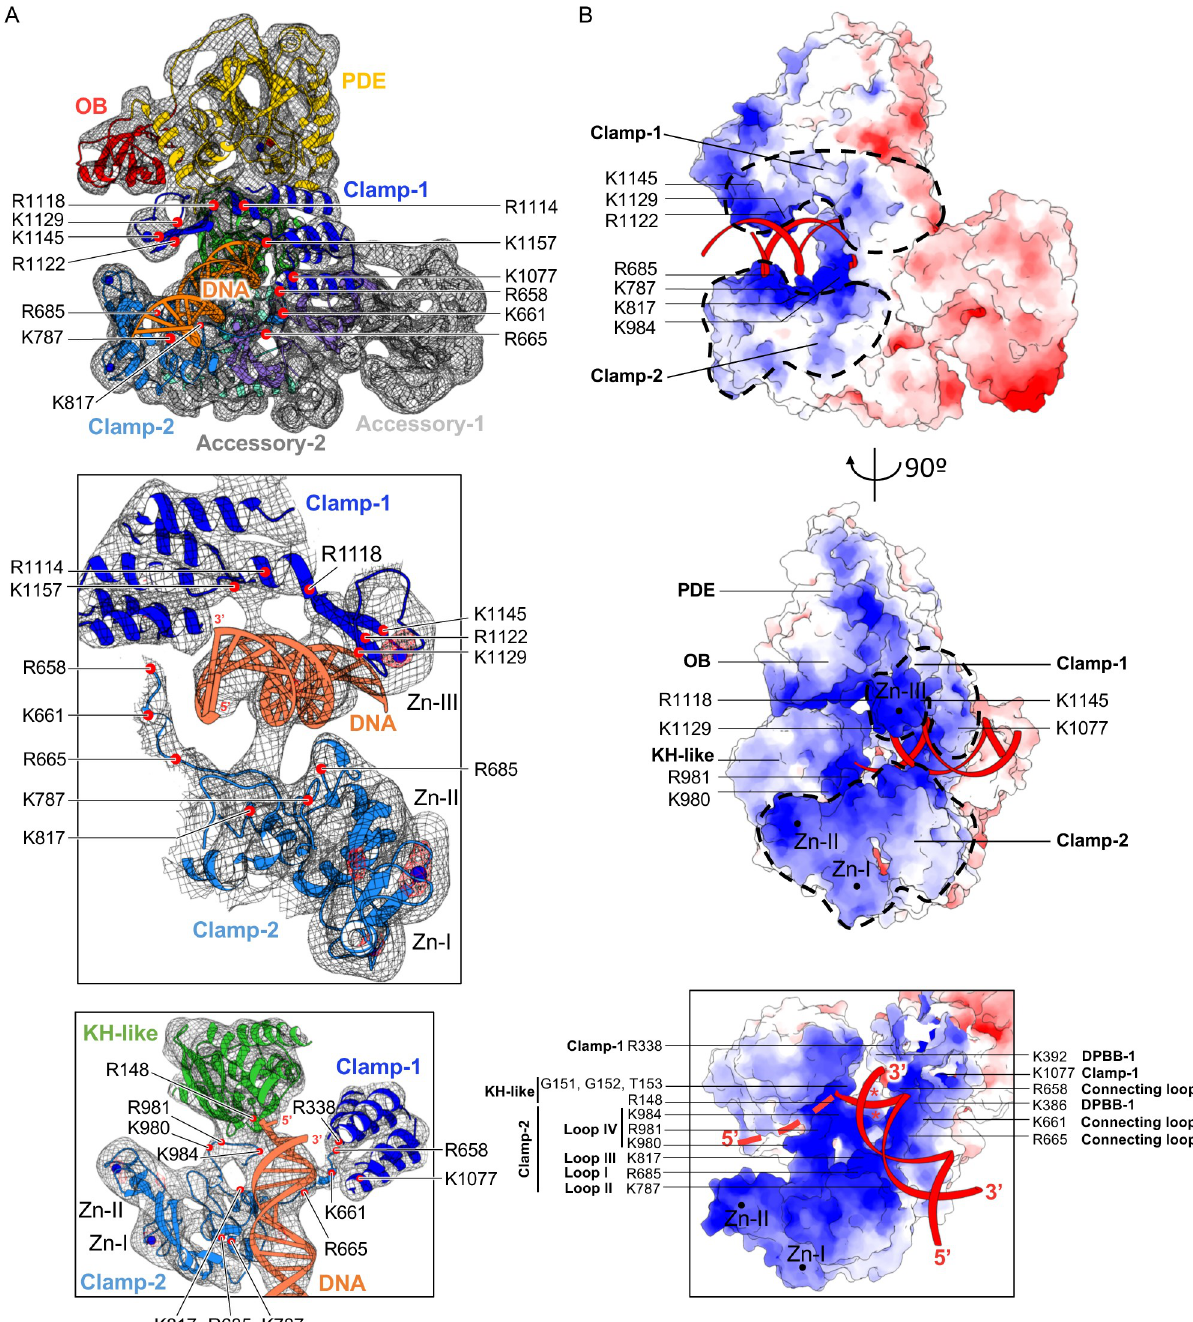
Fig 7. Structure and surface charge distribution of the PolD–DNA-binding site. (A) Selected views of the DNA-bound PolD cryo-EM experimental map. Upper: Overview of the DNA-bound complex. Middle: The minor groove of the nascent DNA duplex is cradled between clamp-1 and clamp-2 domains. Lower: Enlarged view showing the contributions of clamp-1, clamp-2, and the KH-like domain to the PolD–DNA-binding site. For clarity, the Zn-III binding domain is hidden. Density surrounding PolD and DNA is shown as a gray mesh contoured at 6 σ . Residual peaks of density are shown in red mesh contoured at 12 σ . C α of conserved basic residues are shown as red spheres. (B) Surface charge distribution of the PolD–DNA- binding site. The surface of PolD is colored according to the electrostatic surface potential, with negative, neutral, and positive charges shown in red, white, and blue, respectively. The electrostatic surface potential was calculated using a PolD model containing all side-chain atoms. All side chains of DP1 and most side chains of DP2 (86%) were deduced from the existing crystal structures; the others were modeled according to the most likely rotamers. Catalytic aspartic residues are marked by a red asterisk. Zn-binding domains are depicted with black spheres. Clamp-1 and clamp-2 domains are highlighted by dotted lines. The DNA backbone is colored red, and the last 4 nt of the 5 0 template are schematized with red dashes, based